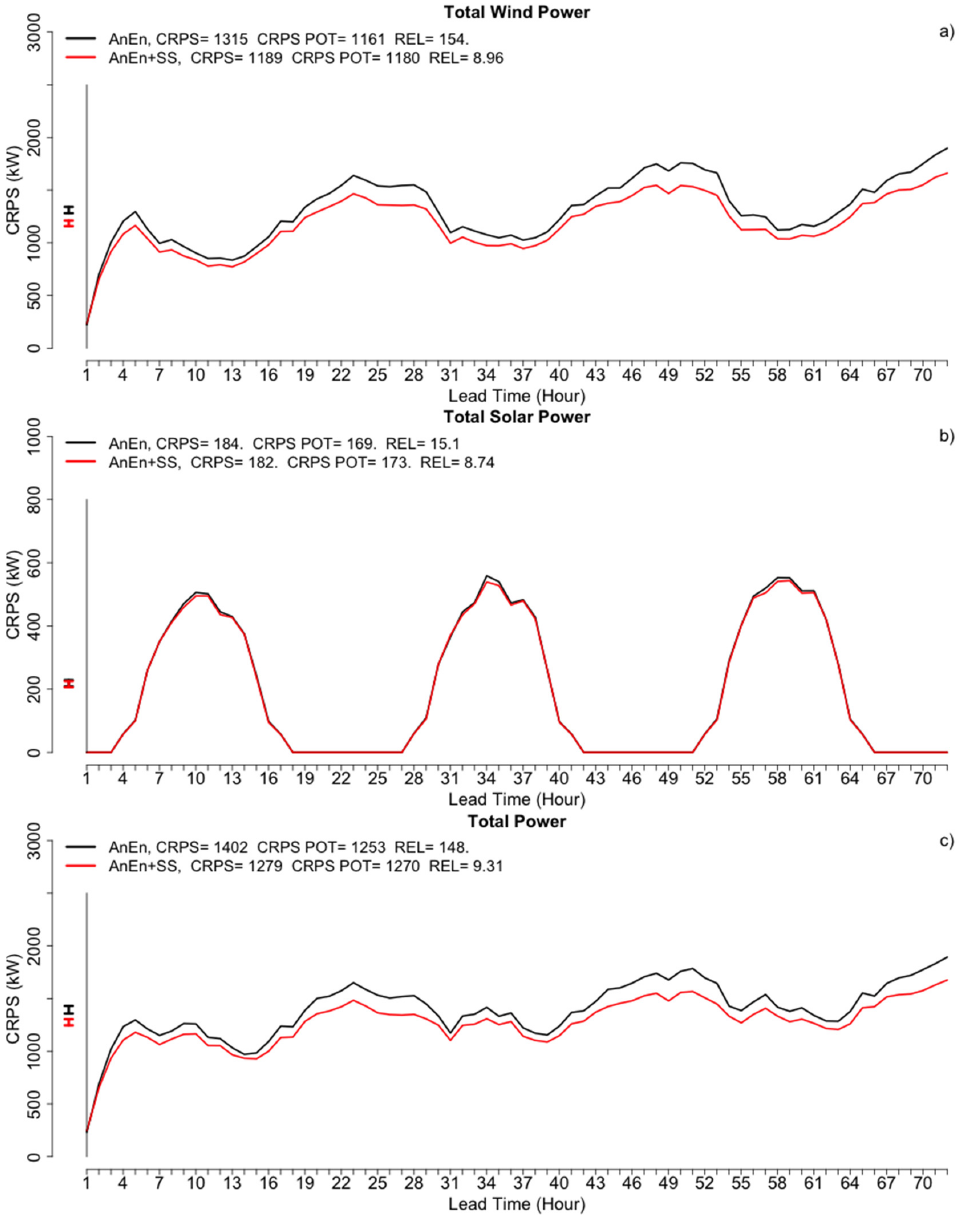
Figure 8. Continuous ranked probability score (CRPS) versus lead time for analog ensemble (AnEn), (black) and AnEn + Schaake shuffle (SS), (red) for total wind power ( a ), total solar power ( b ), and total solar + wind power ( c ). On the left part of the panels, the CRPS values computed pooling all the lead times together are plotted together with the 5th–95th bootstrap confidence interval. At the top of the panels, values of the CRPS, the potential CRPS (CRPSPOT), and the reliability (REL) are indicated.